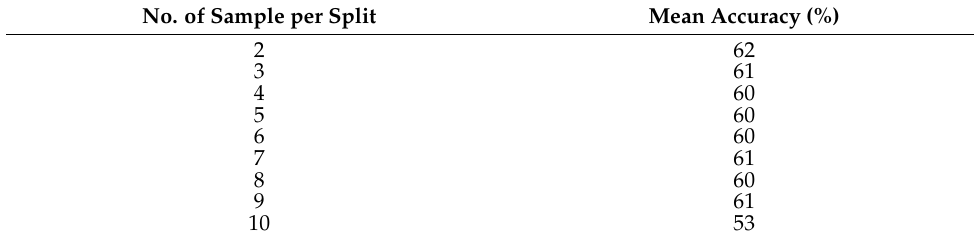
Table 14. Pohang: Predictive accuracy score against the number of samples per